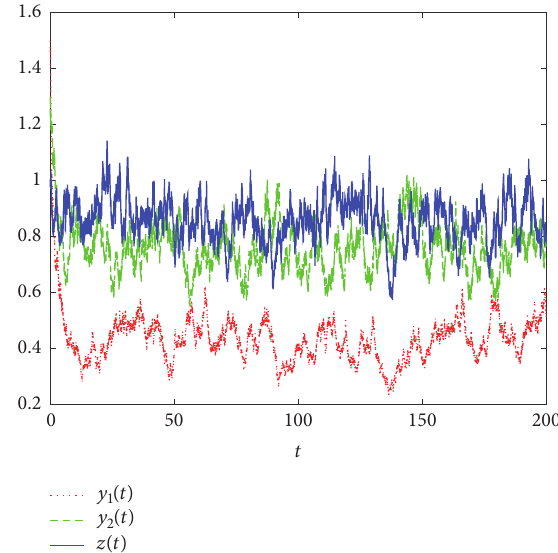
Figure 4: Solution of model (62) for 𝛾 1 (𝜃) = (1.5, 1.3, 1) and 𝜎 𝑖 = 0.1 (𝑖 = 1, 2, 3, 4, 5).